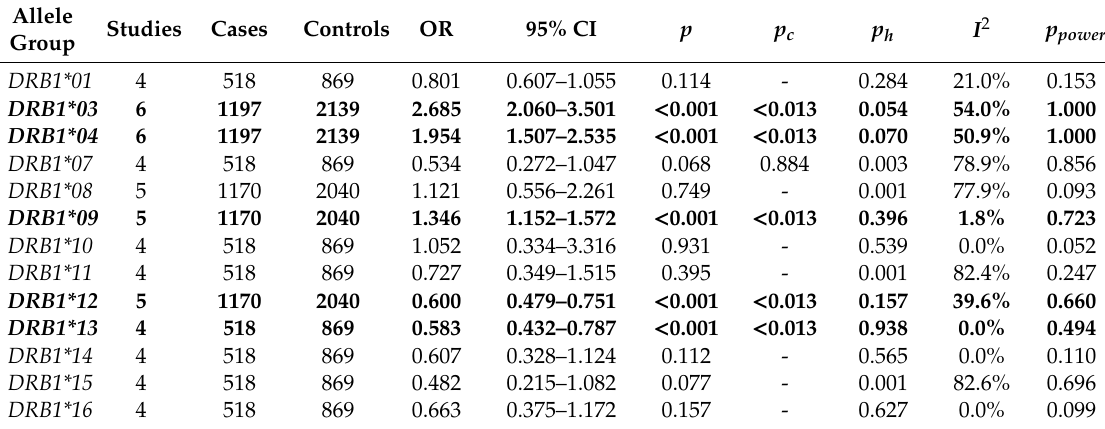
Table 5. Meta-analysis of the association between HLA-DRB1 polymorphisms and susceptibility to